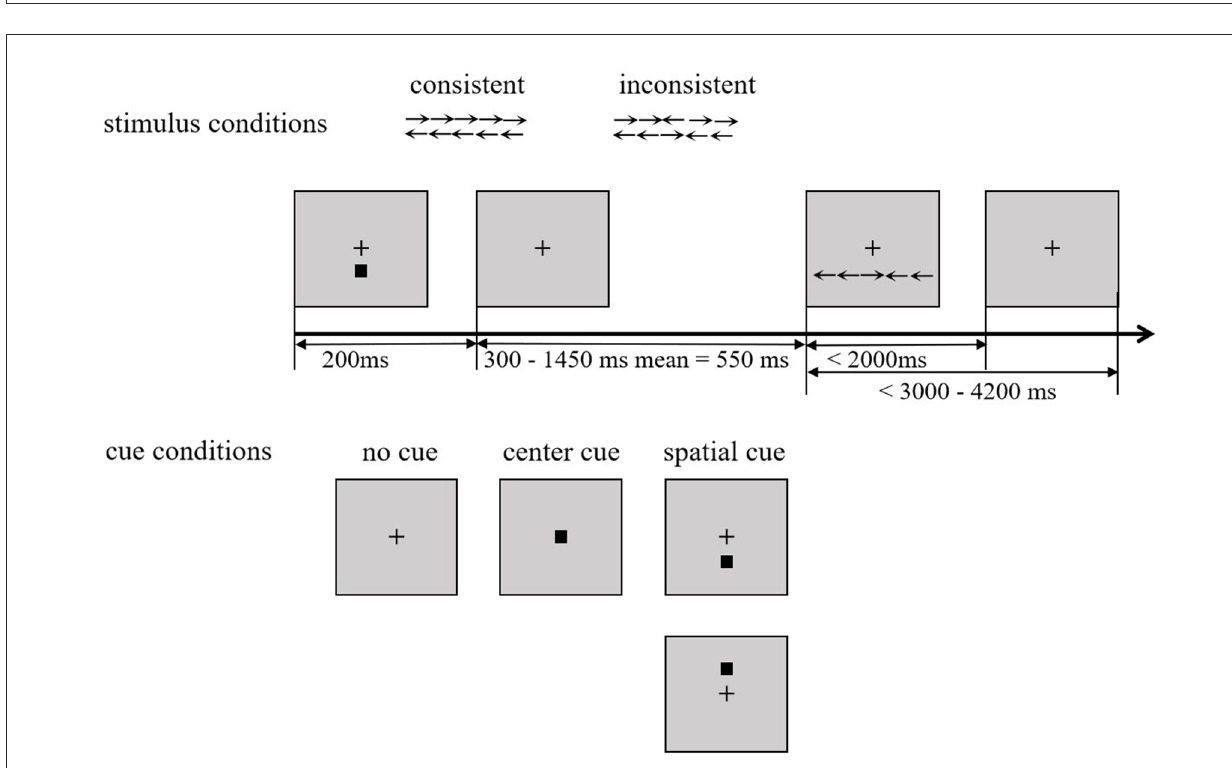
FIGURE2 Flow chart of ANT. ANT, Attention Network